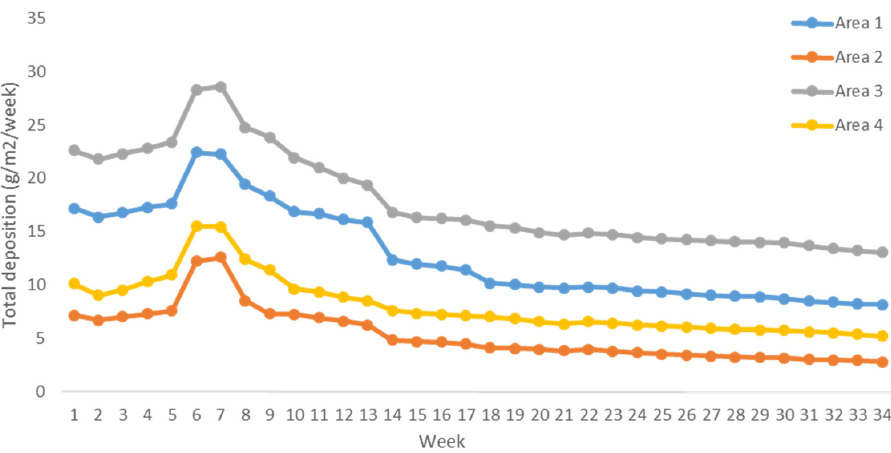
Figure 3. Total depositions in the four areas in both dry and rainy seasons.